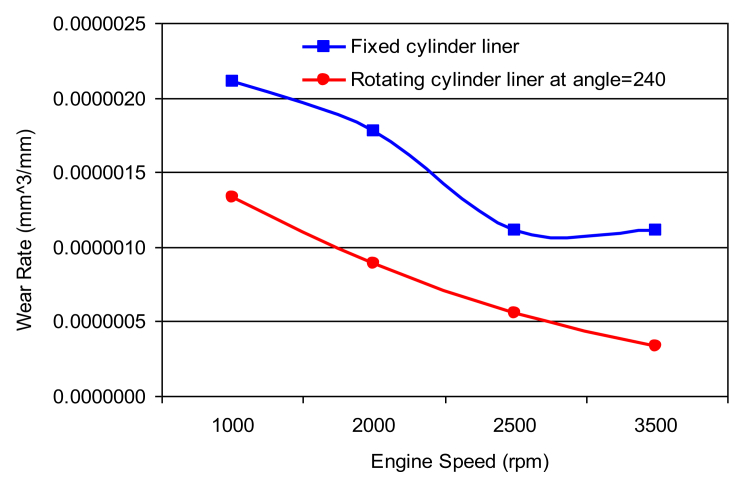
Wear rate of cylinder liner (rotating cylinder liner positioned at 240o angle.